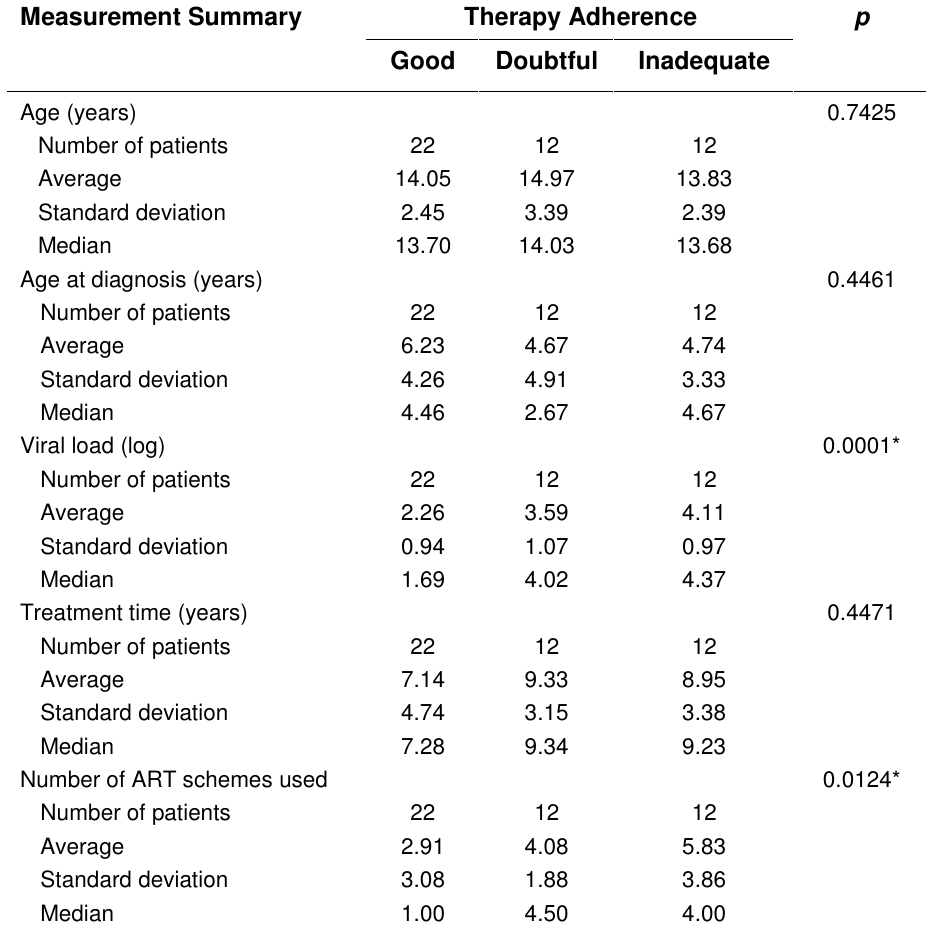
Measurement Summary of Age, Age at Diagnosis, Viral Load (log), Treatment Time, and Number of Antiretroviral Schemes Used in Each Therapy Adherence Level Measurement